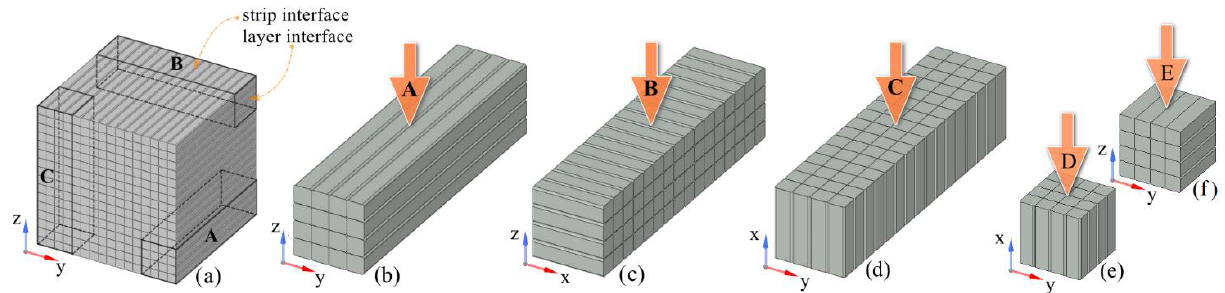
Figure 8. Loading directions. ( a ) Positions of the flexural testing samples: ( b ) type-A loaded along the Z -axis, ( c ) type-B loaded along the Z -axis, ( d ) type-C loaded along the X -axis, ( e ) type-D along the X -axis, and ( f ) type-E along the Z -axis.